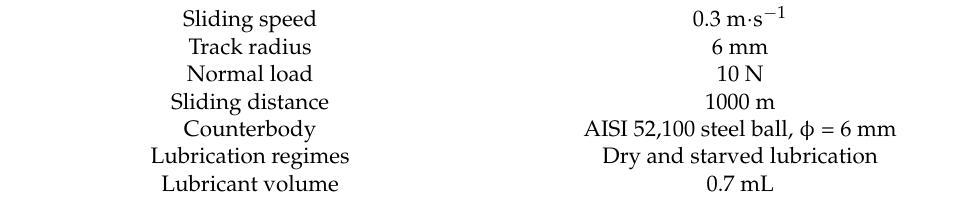
Table 3. Conditions of the tribological